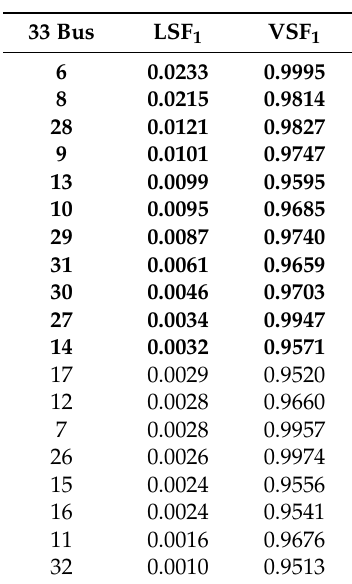
Figure 11. The line diagram of IEEE 33-bus radial distribution network. Table 2. The results of LSF and VSF of 33-bus IEEE distribution